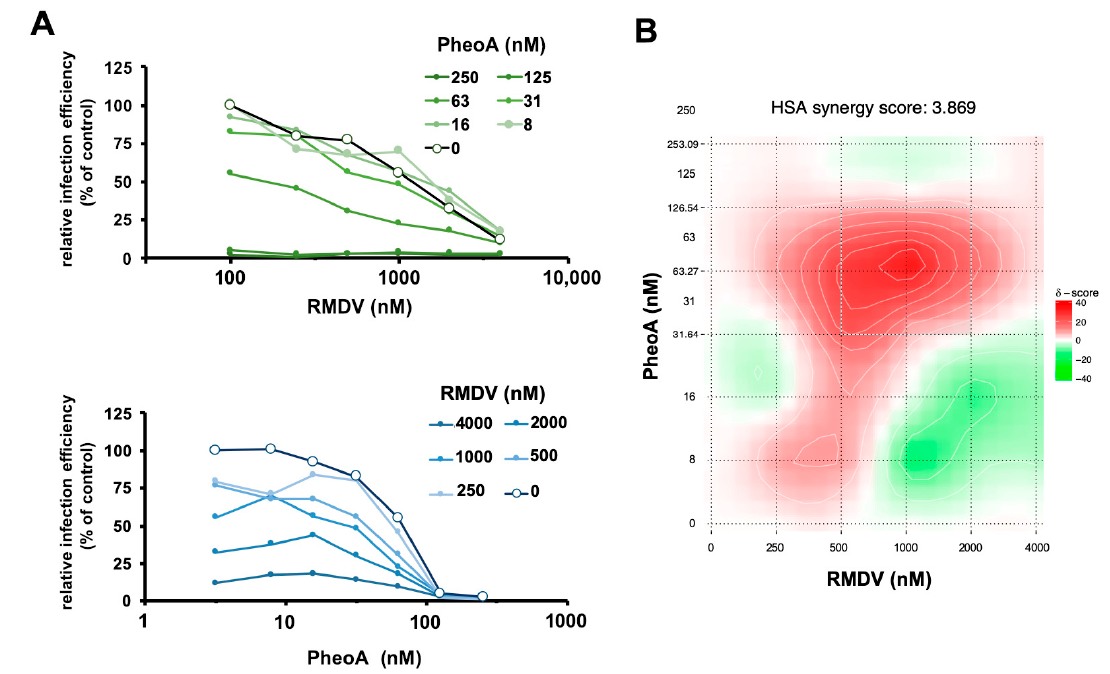
Figure 6. Combination treatment of PheoA with RMDV. Vero E6 cells were inoculated at MOI = 0.005 in the presence of increasing concentrations of PheoA in combination with increasing doses of RMDV. Twenty-four hours post infection, cells were fixed and processed for automated immunofluorescence microscopy. Relative infection efficiency values were estimated as percentage of the values obtained in mock-treated cells. ( A ) Data are shown as average of two biological replicates. ( B ) Heatmap describing the areas of synergy within the combination